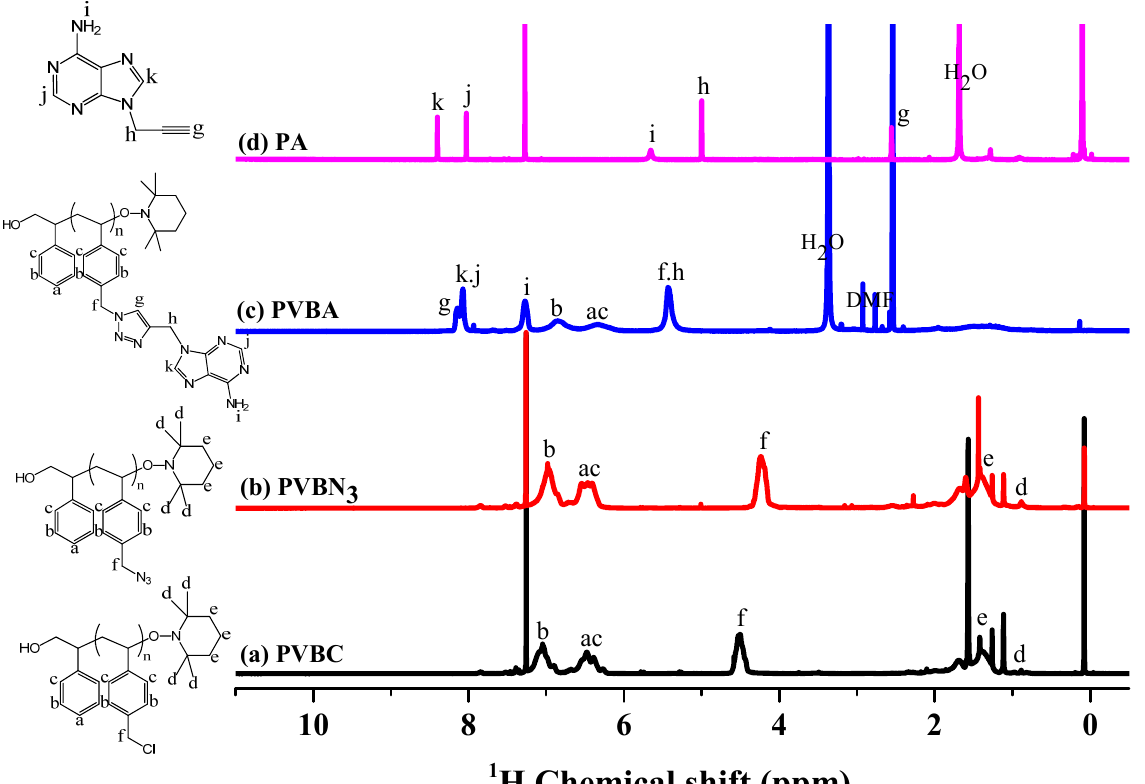
Figure 1. 1 H NMR spectra of ( a ) PVBC in CDCl d -DMSO; and ( d ) PA in CDCl 6